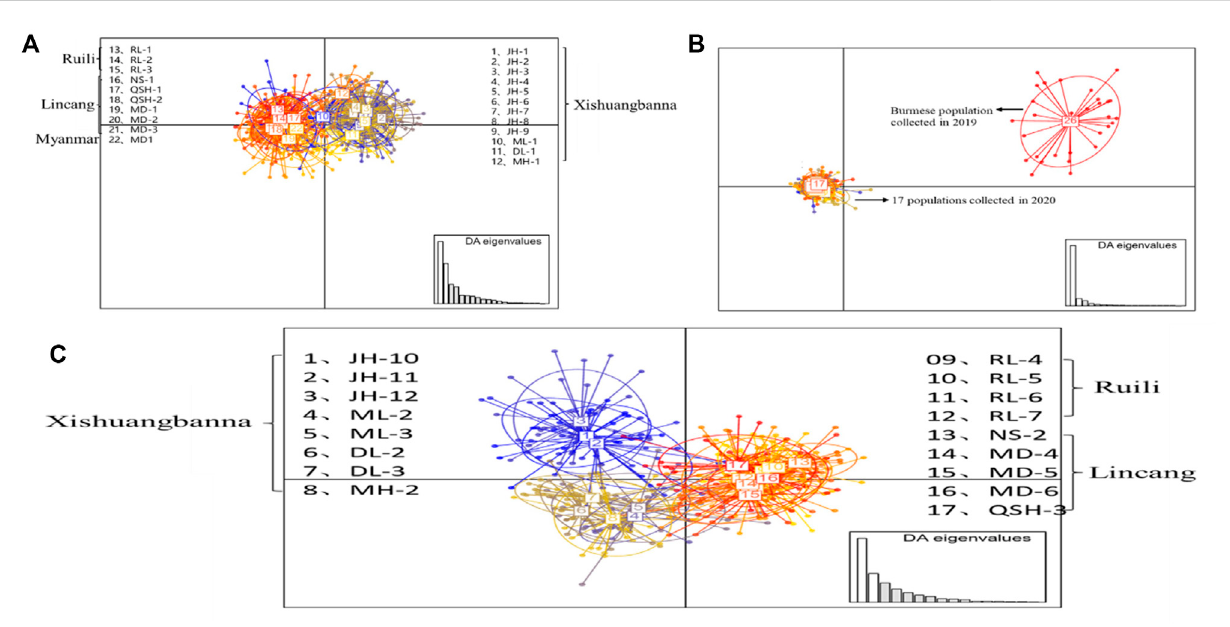
FIGURE 3 DAPC analysis of Ae. aegypti population structure based on microsatellite loci in the border areas of Yunnan Province. Each circle represents a cluster and each color represents the different subpopulations identi fi ed by the DAPC. Panel (A) represents the DAPC results for the 22 populations sampled in 2019; panel (B) represents DAPC results of collected population in 2019 and 2020; panel (C) represents the DAPC results for the 17 populations sampled in